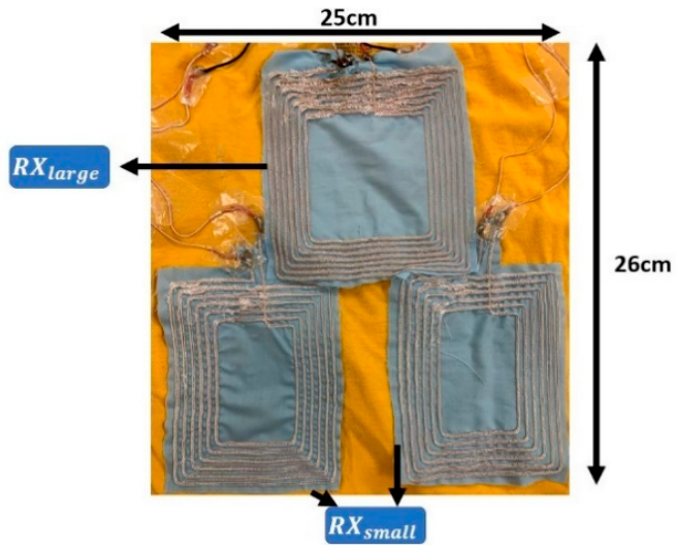
Figure 4. Embroidered RX coil array.